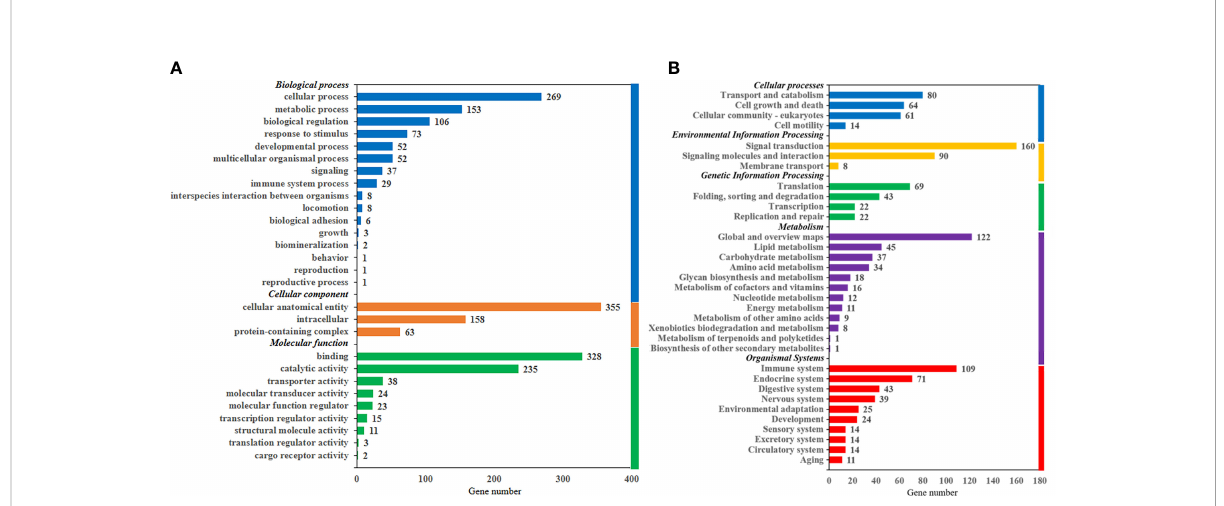
FIGURE 3 Gene Ontology annotations (A) and Kyoto Encyclopedia of Gene and Genomes classi fi cation (B) of differentially expressed genes in the liver transcriptome of largemouth